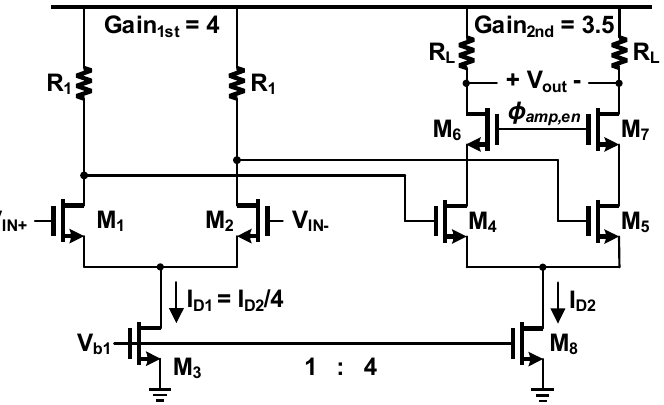
Figure 14. Open-loop residue amplifier. Reprinted with permission from Ref. [22]. Copyright 2019 the Japan Society of Applied Physics.